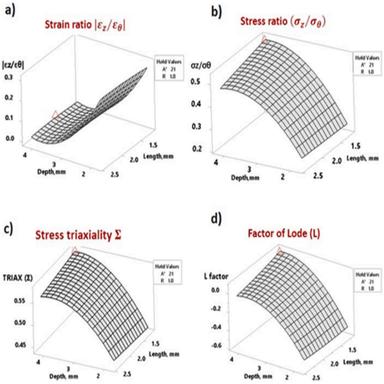
Surface plot of outputs indicators: (a) Stress ratio ( σzz σθθ ); (b) Triaxiality ( ∑); (c) Lode parameter (L) and (d) ⃒ ⃒ ⃒ εzz εθθ ⃒ ⃒ ⃒ against the variation of the depth and the width of the gauge zone of the RHPST specimen.